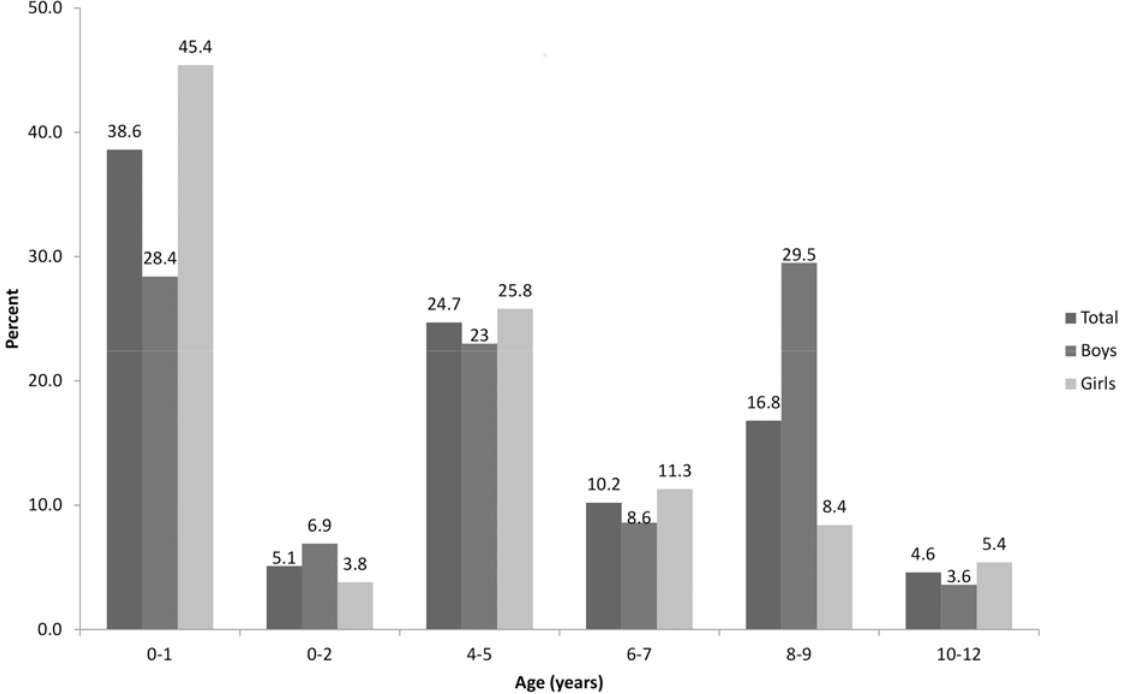
Fig 2. Age distribution of asthma-like symptoms, by gender, among the 801 children included in the ENFAMS survey (n = 147)